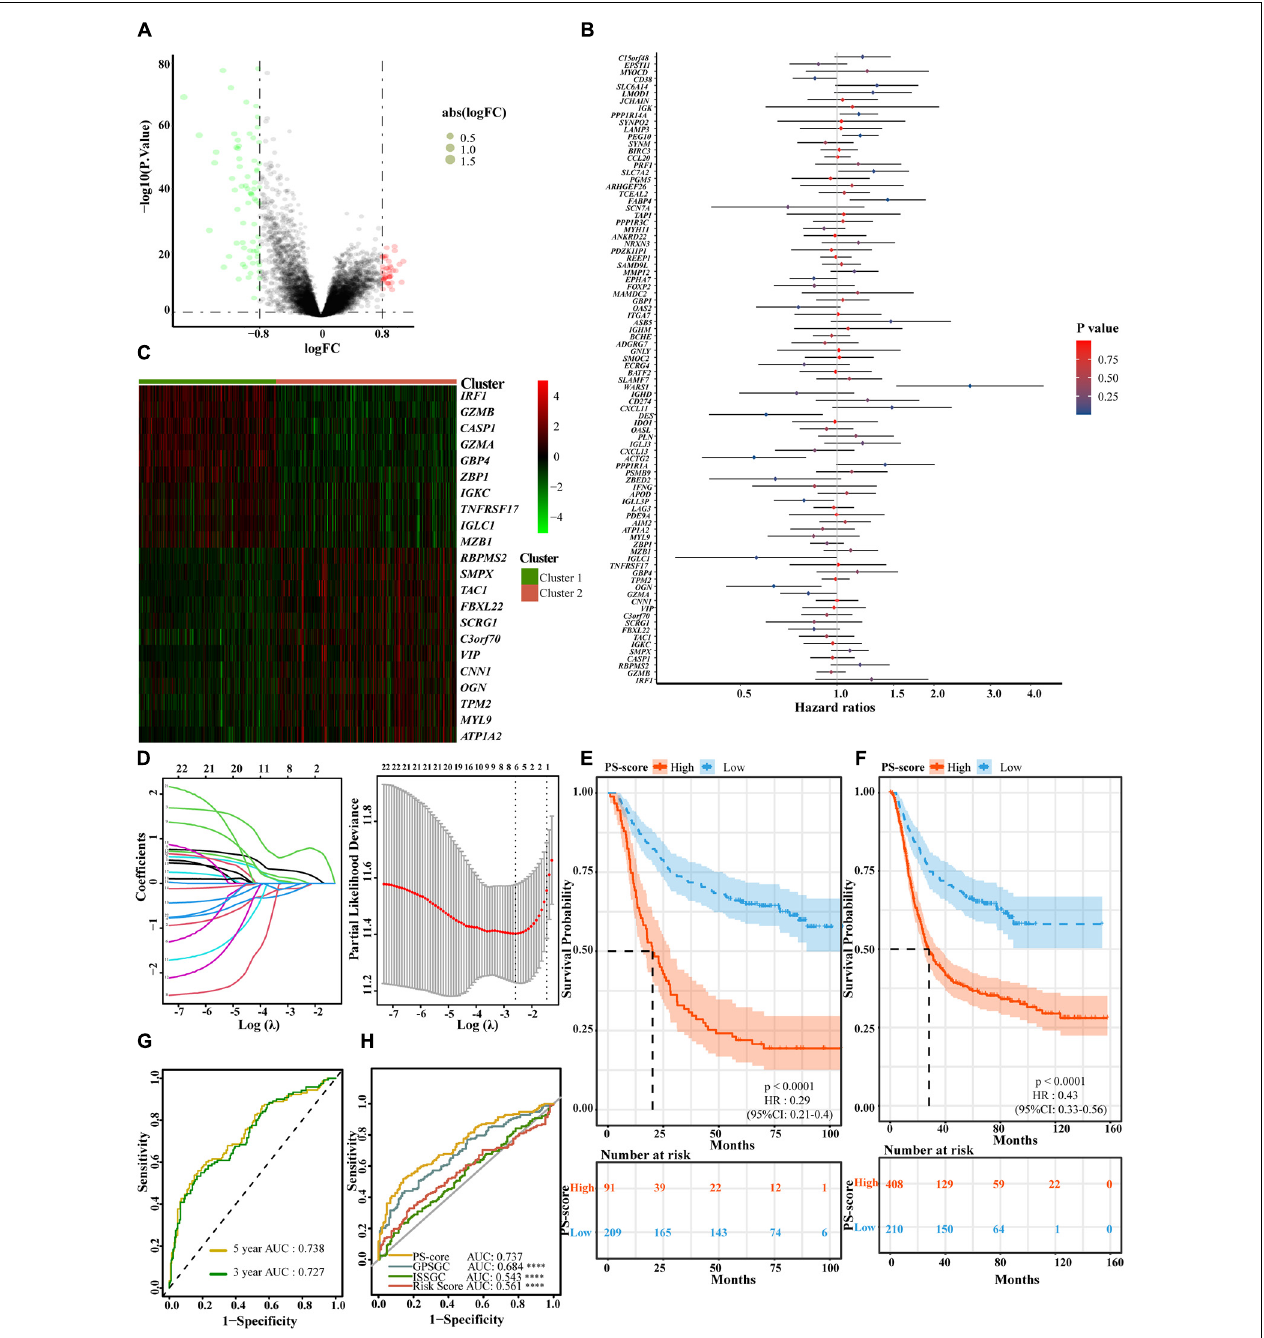
FIGURE 4 | Generation of a gene expression signature to predict patient survival based on pyroptosis-related clusters. (A) An overview of the differential gene expression between the two pyroptosis-related clusters in GEO cohorts (GSE15459, GSE34942, GSE57303, and GSE62254). (B) Multivariate Cox regression analyses of OS in GEO cohorts (GSE15459, GSE34942, GSE57303, and GSE62254). The p -values were obtained by multivariate Cox regression. No Cox regression assumptions were violated assessed using the SPSS 26 software. (C) Unsupervised clustering of independent prognostic genes in GEO cohorts (GSE15459, GSE34942, GSE57303, and GSE62254). Columns of the heatmap represented 618 patients with gastric cancer. (D) In the LASSO-Cox model of GSE62254, the minimum standard was adopted to obtain the value of the super parameter λ by 10-fold cross-validation. The λ value was confirmed as 0.07558 where the optimal lambda resulted in 6 non-zero coefficients. (E) OS curves for the different PS-score subgroups with the cut-off value 1,258 about 300 patients with gastric cancer from GSE62254 cohort (Log-rank test, p < 0.0001). (F) OS curves for the different PS-score subgroups with the cut-off value 1 · 258 among 618 gastric cancer samples from four GEO cohorts (GSE15459, GSE34942, GSE57303, and GSE62254) (Log-rank test, p < 0.0001). (G) The time-dependent receiver operating characteristic (ROC) analysis of the PS-score. The area under the curve (AUC) was 0.727, 0.738 at 3 years, and 5 years, respectively, in GSE62254 cohort. (H) ROC curves about PS-score ISSGC Score, Risk Score, and GPSGC Score in GSE62254 cohort (Mann Whitney tests; compared with PS-score, ∗∗∗∗ P < 0.0001).